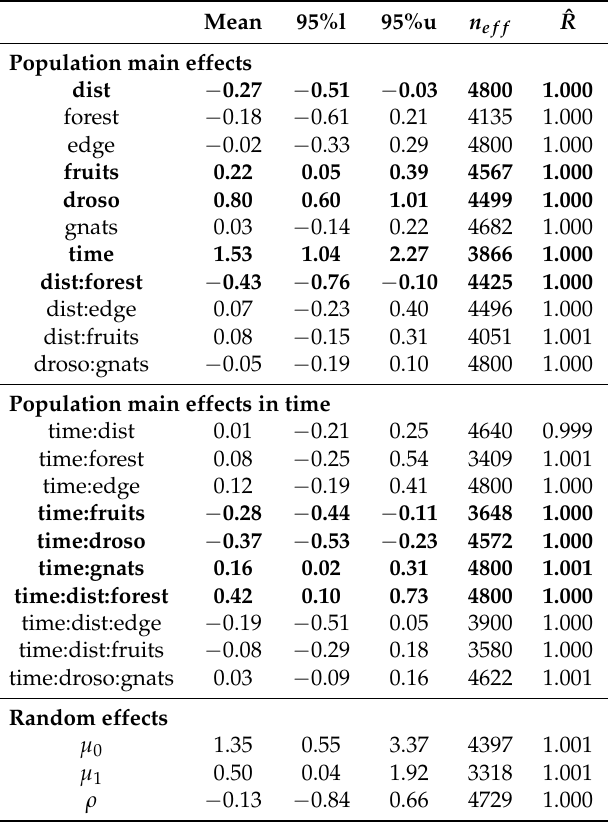
Table 2. Posterior means and their lower (95%l) and upper (95%u) high density posterior intervals from a negative binomial Bayesian mixed model with N = 5 groups and n = 360 observations. Variables not including zero in the intervals are highlighted in bold. Abbreviations: dist = distance to nearest forest, forest = forest area, edge = edge density of forest patches, fruits = availability of cherries, droso = abundance of other drosophilid flies, gnats = abundance of gnats from the genus Sylvicola , time = calendar week, µ 0 = mean intercept from orchards, µ 1 = mean slope from time, ρ = correlation between intercept and slope, n ef f = number of independent a posteriori values drawn from chains, ˆ R = scale reduction